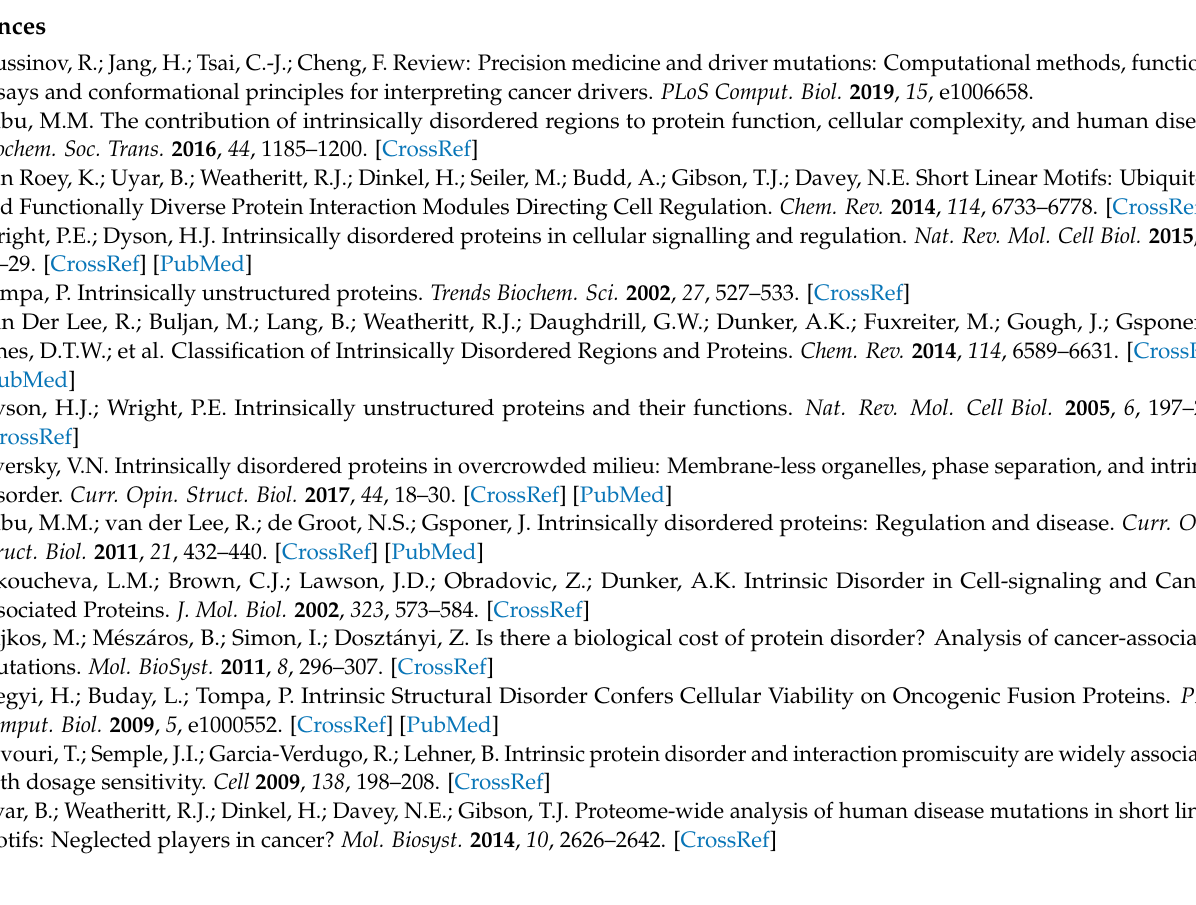
Table S6: Gene Ontology terms used in the quantification of hallmarks of